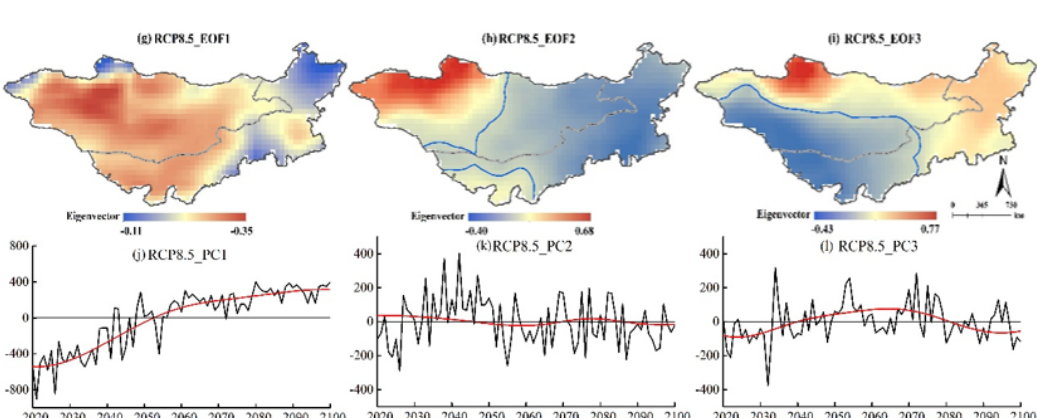
Figure 10. First three eigenvectors (EOF1, EOF2 and EOF3) and their corresponding principal component (PC) series for the annual standardized precipitation evapotranspiration index (SPEI) under RCP4.5 ( a – f ) and RCP8.5 ( g – l ) scenarios during 2020–2100 for the Mongolian Plateau. The blue line indicates the eigenvalue equal to 0.